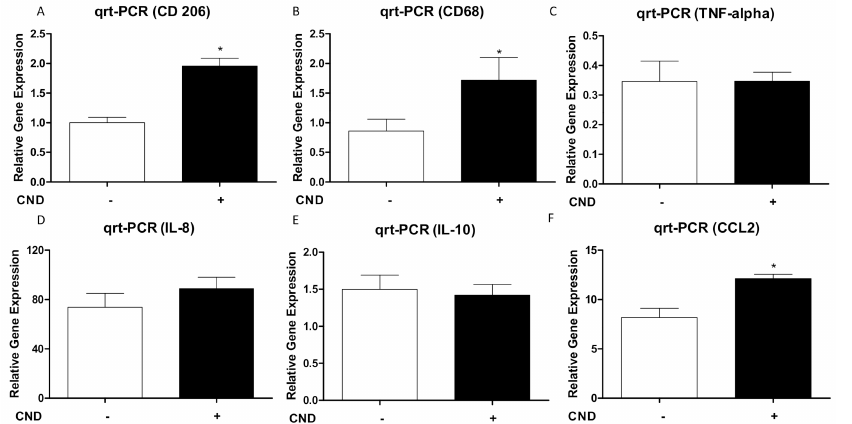
Figure 5. Effect of CNDs on expression of M1/M2 biomarkers in macrophages. THP-1 cells (1 × 10 6 ) were treated with 3 ng/mL TPA in the presence or absence of 0.1 mg/mL CNDs in RPMI media for 72 h, upon which media was refreshed. Then, cells were left to incubate and mature for another 72 h. RNA was isolated, converted to cDNA, and probed for CD206 ( panel A ), CD68 ( panel B ), TNF-alpha ( panel C ), IL-8 ( panel D ), IL-10 ( panel E ), and CCL2 ( panel F ) using SYBR green qRT-PCR reagents via an Applied Biosystems™ StepOne™ Real-Time PCR System. GAPDH was the housekeeping gene. All data represent mean ± SEM. ( n = 4–6, *, p < 0.05 vs.